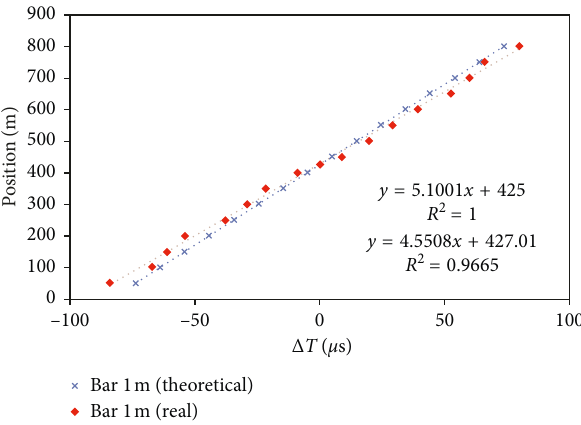
Figure 7: Time delay for different impacts; steel bar of